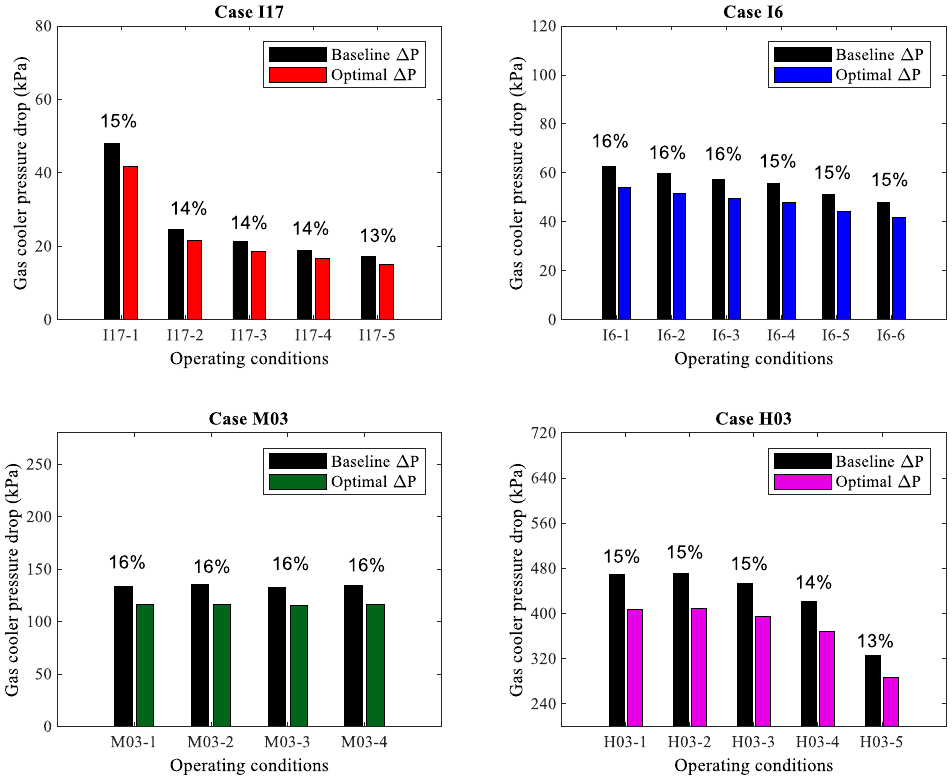
Figure 7. Pressure drop percentage improvement compared with the baseline geometry of the